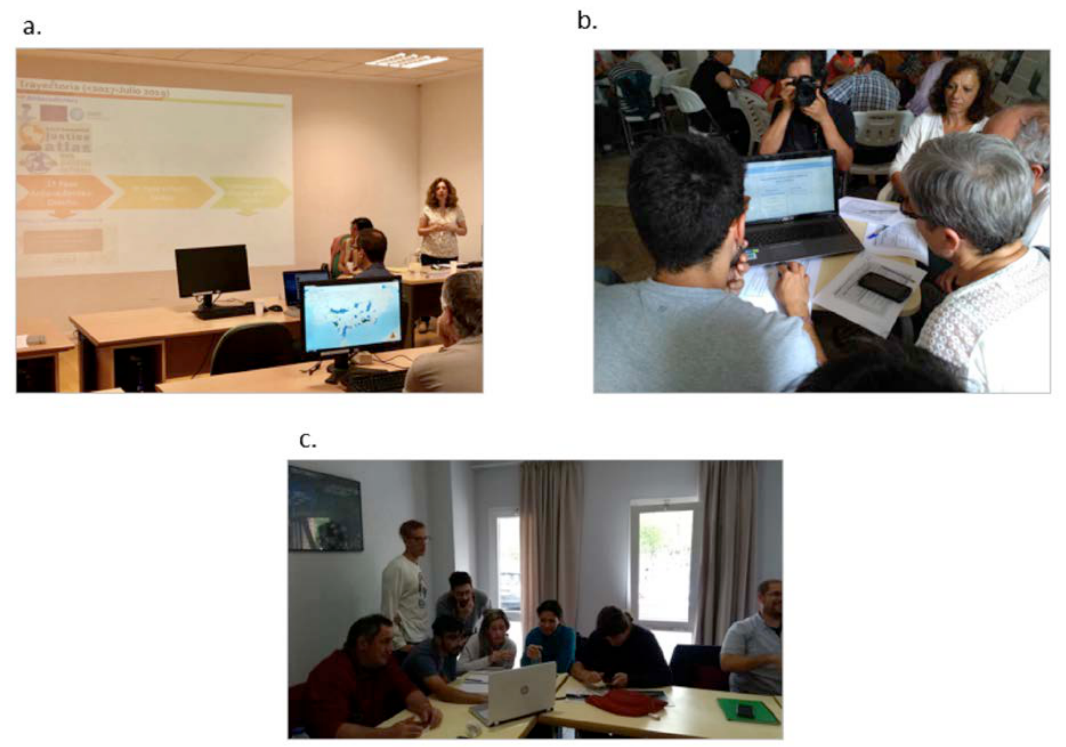
Figure 3. Mapping workshop process. ( a ) Introduction to the Project; ( b ) testing the web-design tool through map consultation and by adding a water conflict report; ( c ) gathering opinions and suggestions using a semi-structured questionnaire in Google-form format.